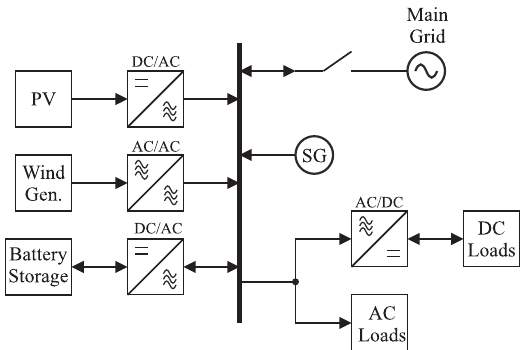
Figure 1. An AC microgrid in which dynamics are dominated by power electronics